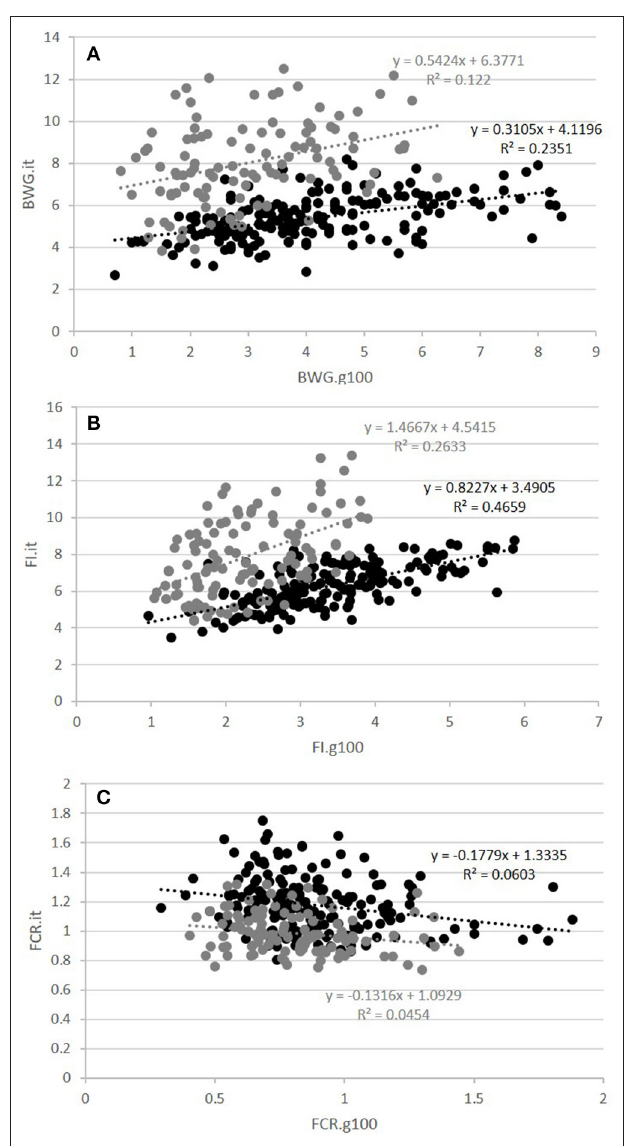
FIGURE 4 | Relations between fish reared in groups and fed with an optimal feed ration (g100) and fish reared in isolation with a restricted ration (it) for BWG (A) , FI (B) , and FCR (C) . Black and gray circles corresponded to individuals of the GIFT and Cirad strains, respectively. The equation of the linear regression and the coefficient of determination R 2 are surrounded in black and gray for the GIFT and the Cirad strain,